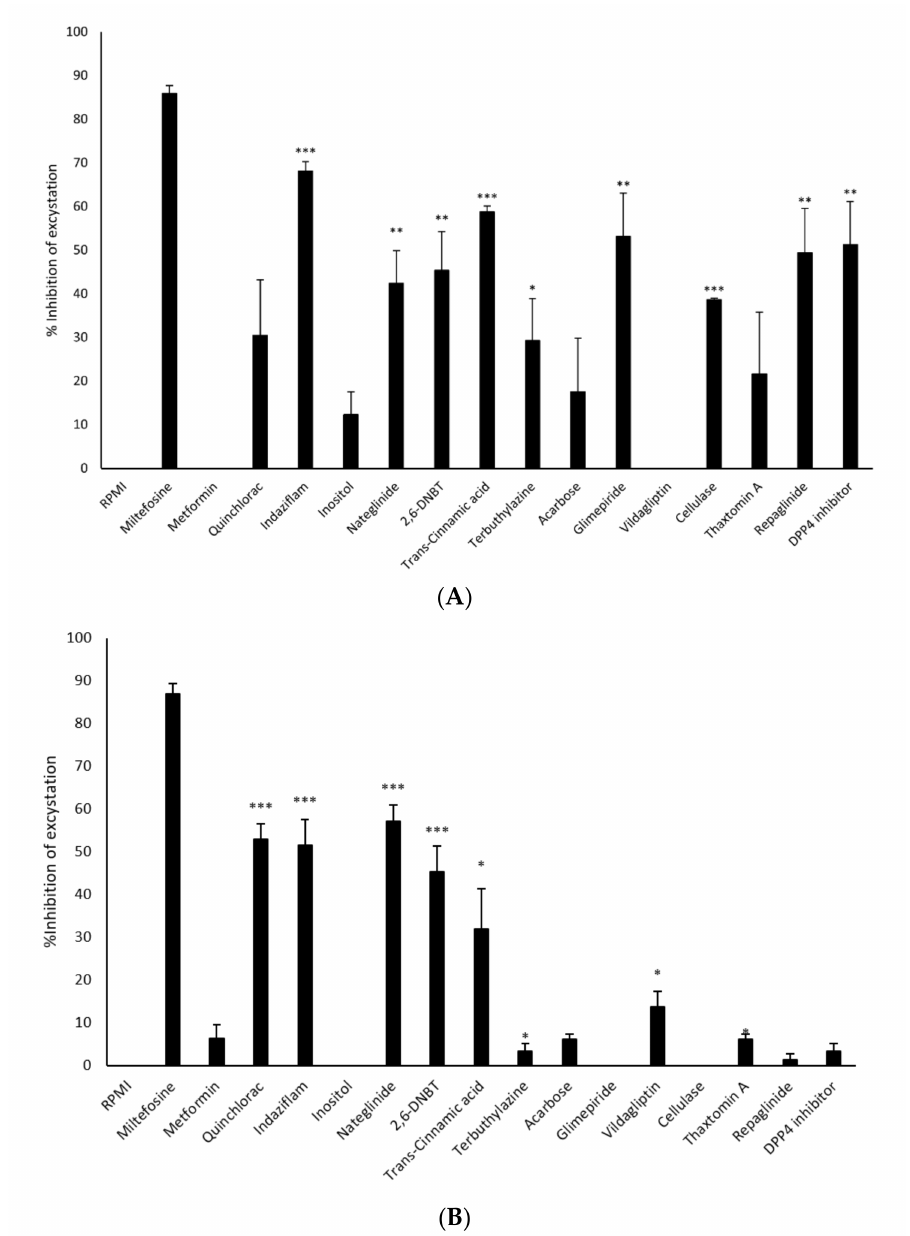
Figure 3. ( A ) Inhibition of excystation of N. fowleri cysts. N. fowleri cysts were incubated with 100 µ M drugs and/or solvent in 24-well plates containing RPMI-1640 on HeLa monolayers for 24 h and number of viable trophozoites were then enumerated. Percentage inhibition of excystation was